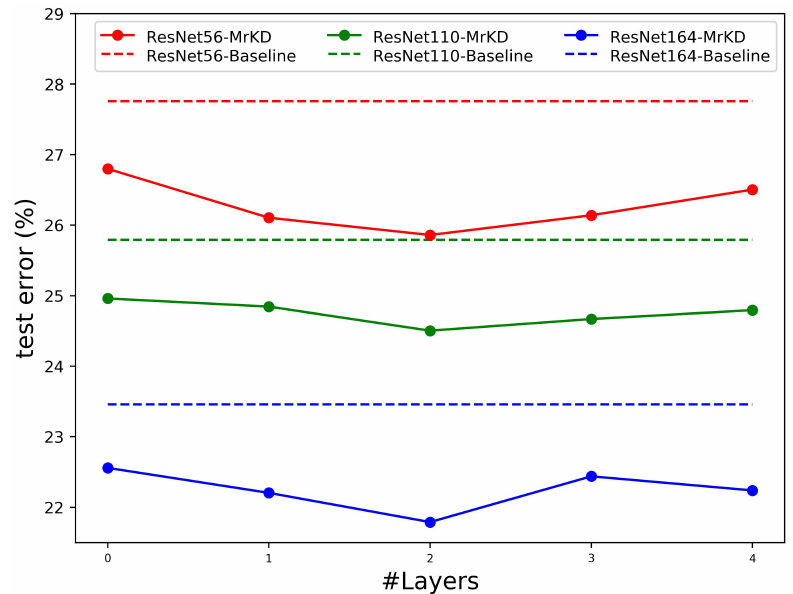
Figure 9. Performance of MrKD on CIFAR-100 with different depth